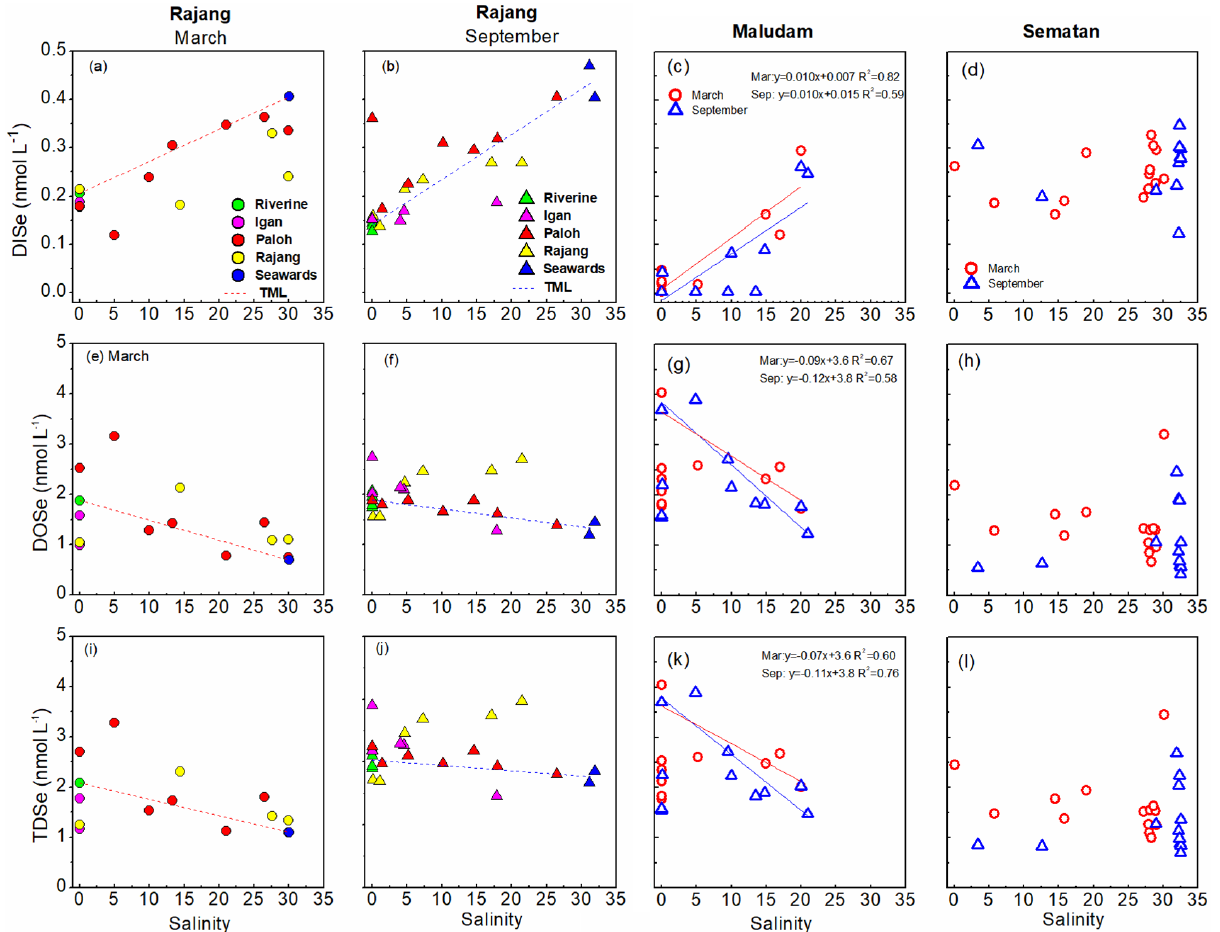
Figure 3. Relationships between DISe (a–d) , DOSe (e–h) and TDSe (i–l) concentrations with salinity in the Rajang and three Rajang tributaries (Igan, Lassa and Rajang) and in the Maludam and Sematan estuaries in March and September 2017. TML refers to the theoretical mixing line, which was defined using two endmembers: freshwater in the riverine system and